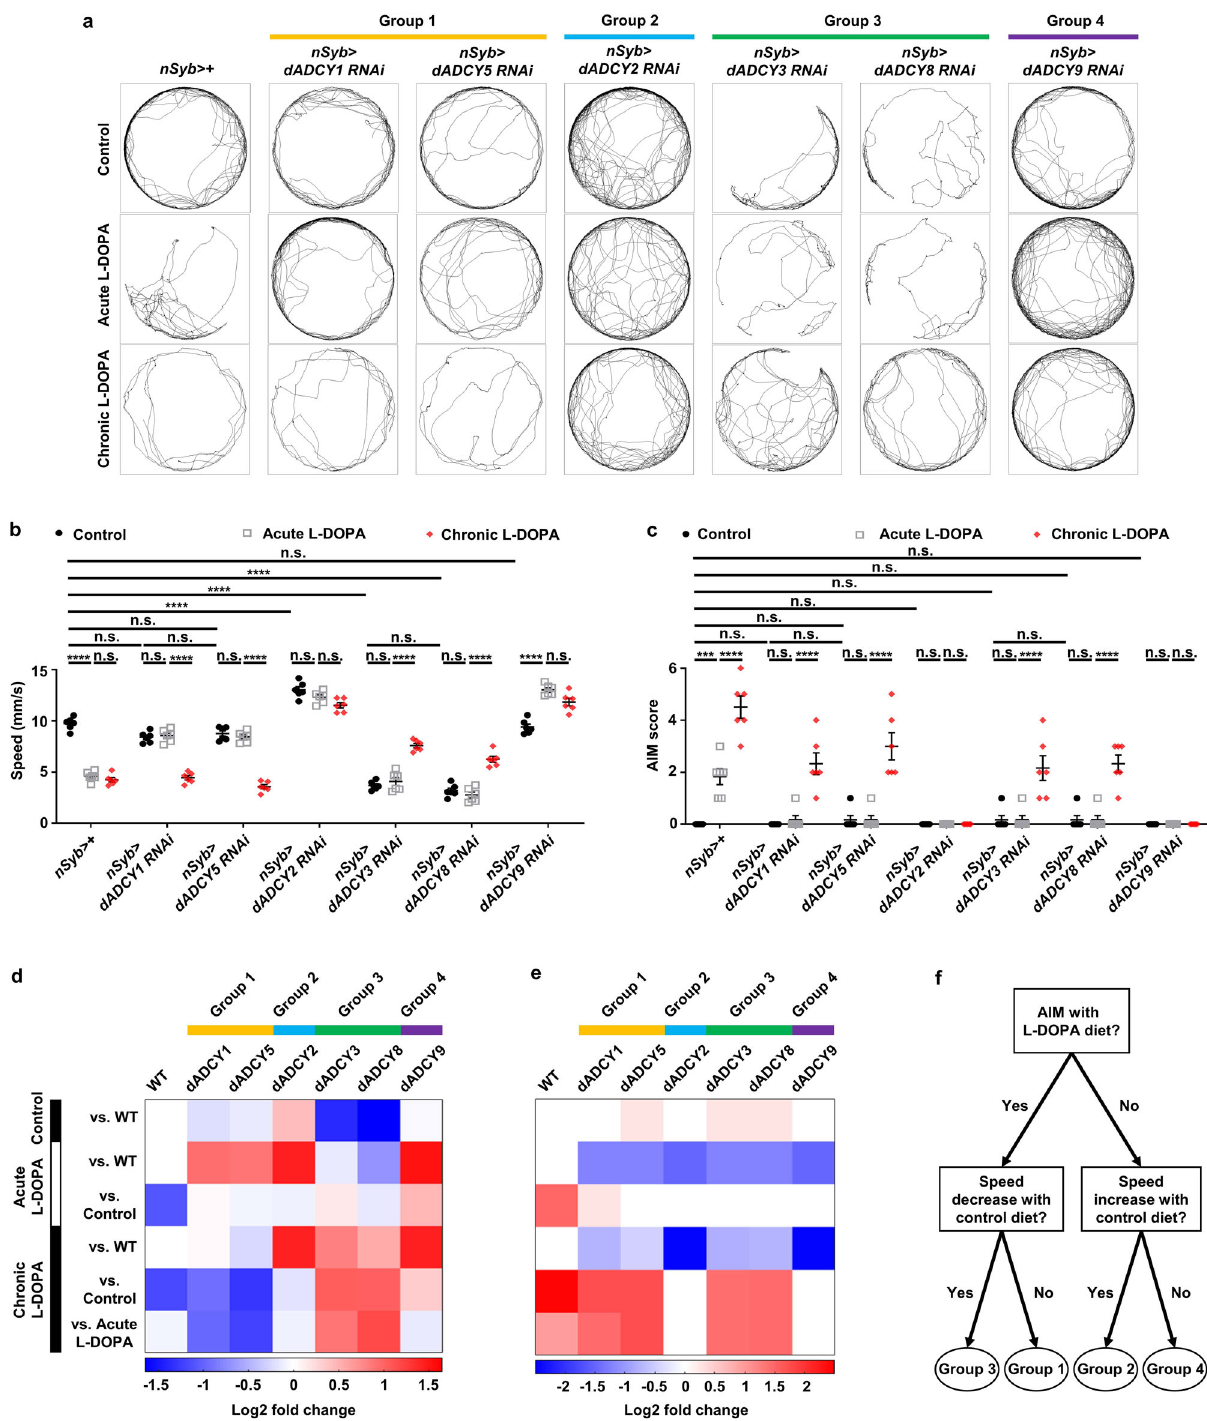
Fig. 7 Phenotypical classi fi cation of the fl y ADCY family reveals four distinct groups. a Representative trajectories of the fl ies with indicated genotypes upon control, acute and chronic L-DOPA diet. b , c Comparisons of the quanti fi ed speed ( b ) and AIM score ( c ) of the fl ies with indicated genotypes upon control, acute, and chronic L-DOPA diet. N = 6. **** p < 0.0001; *** p < 0.001; n.s., not signi fi cant ( p > 0.05) by two-way ANOVA Tukey ’ s multiple comparison test. Data are presented as means ± SEM. p < 0.05 was considered statistically signi fi cant. d , e Heatmaps of quanti fi ed speeds and AIM scores in the fl ies with pan-neuronal knockdown of the four ADCY groups upon normal diet (control), acute and chronic L-DOPA diet. Blues indicate decrease and reds indicate increase of the log2 fold change. f A decision tree to illustrate the selection criteria for the ADCY overexpression of Dop1R1 , suggesting that dADCY2 functions slows down locomotor speed in normal situations. Upon downstream of Dop1R1. L-DOPA diet, non-physiologically high levels of dopamine are Taken together, we propose that the D1-like family receptor- synthesized by L-DOPA-dopamine conversion pathway in the ADCY2 signaling axis in the postsynaptic dopamine neurons presynaptic neurons. This can lead to pathogenic levels of D1-like